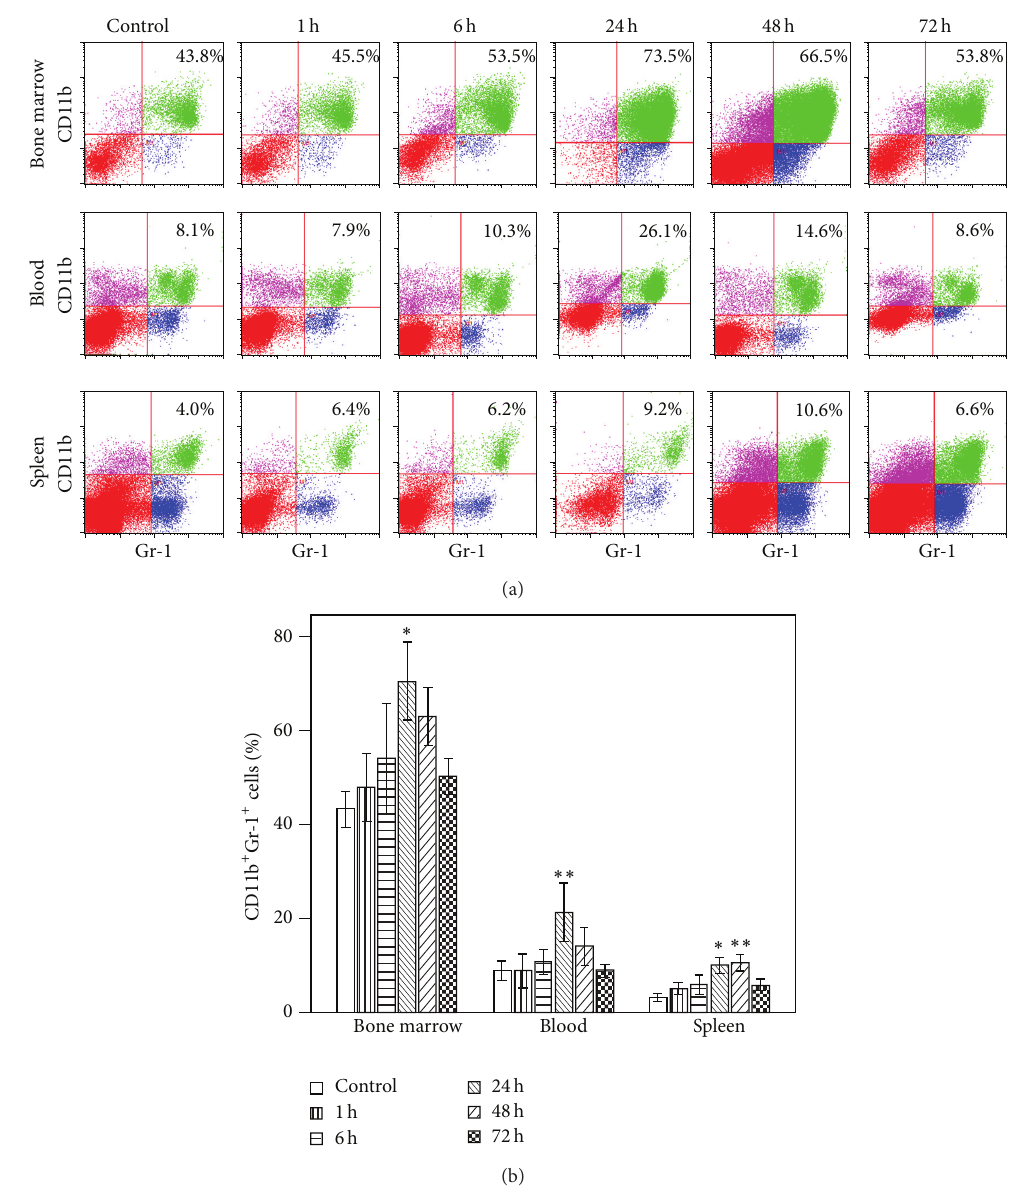
Figure 1: Time course of the changes in accumulation of CD11b + Gr-1 + myeloid-derived suppressor cells (MDSCs) after pseudofracture (PF) in mice. (a) Representative flow cytometric analysis and (b) graphic analysis of the percentages of CD11b + Gr-1 + cells in bone marrow cells, blood leukocytes, and splenocytes in mice at time points after injury. ∗ 𝑃 < 0.05 ; ∗∗ 𝑃 < 0.01 versus control time point. Data represent means ± SEM; 𝑛 = 3 mice per time